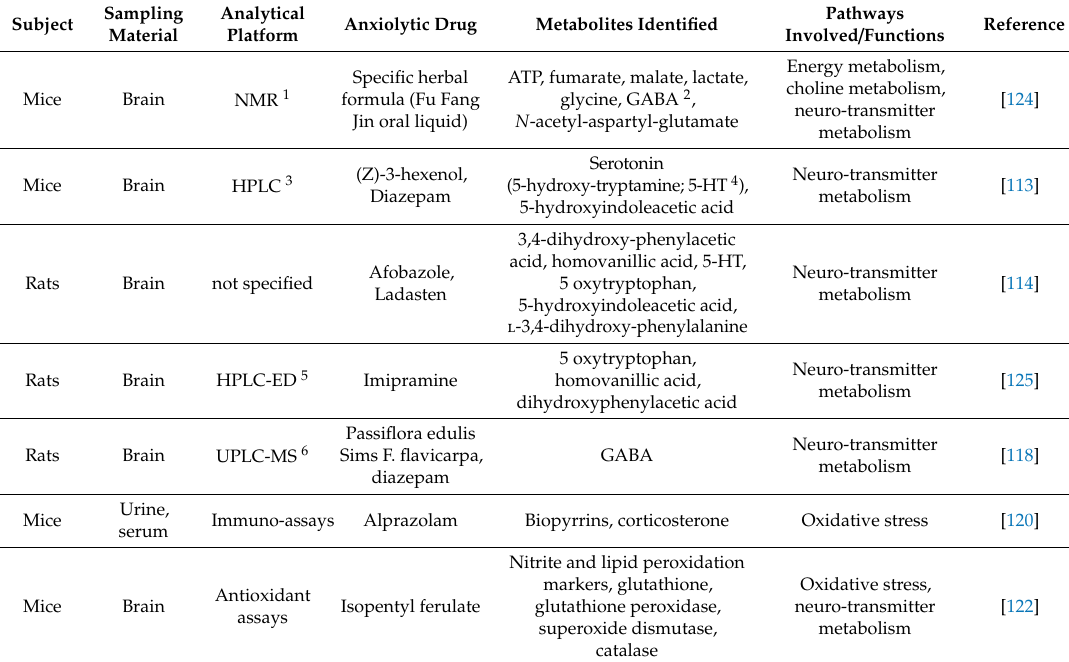
Table 2. Overview of metabolomic studies in the study of anxiolytic e ff